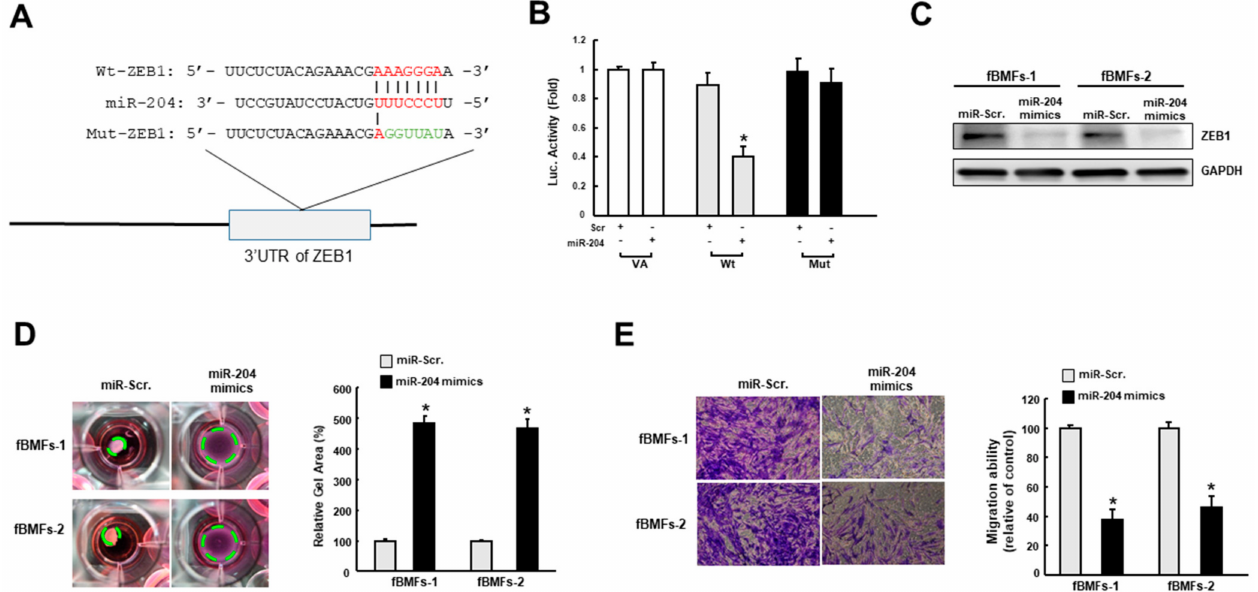
Figure 5. MiR-204 directly binds to the 3 (cid:48) -untranslated region (3 (cid:48) -UTR). ( A ) Schematic presentation of the constructed 3 (cid:48) -UTR plasmids of wild-type (Wt) and mutated (Mut) ZEB1; ( B ) the luciferase activity of each combination was measured and only WT reporter activity was inhibited by miR-204; the protein expression of ZEB1( C ), collagen gel contractility ( D ), and migration ability ( E ) in two fBMFs transfected with miR-Scr. or miR-204 mimics were examined. * p < 0.05 compared to miR-Scr.